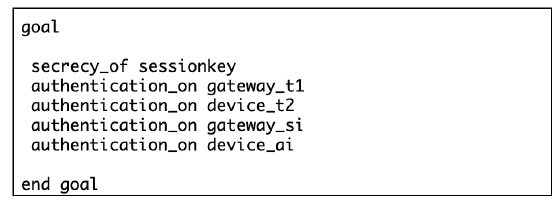
Figure 6. Specification of security goals of the proposed scheme.